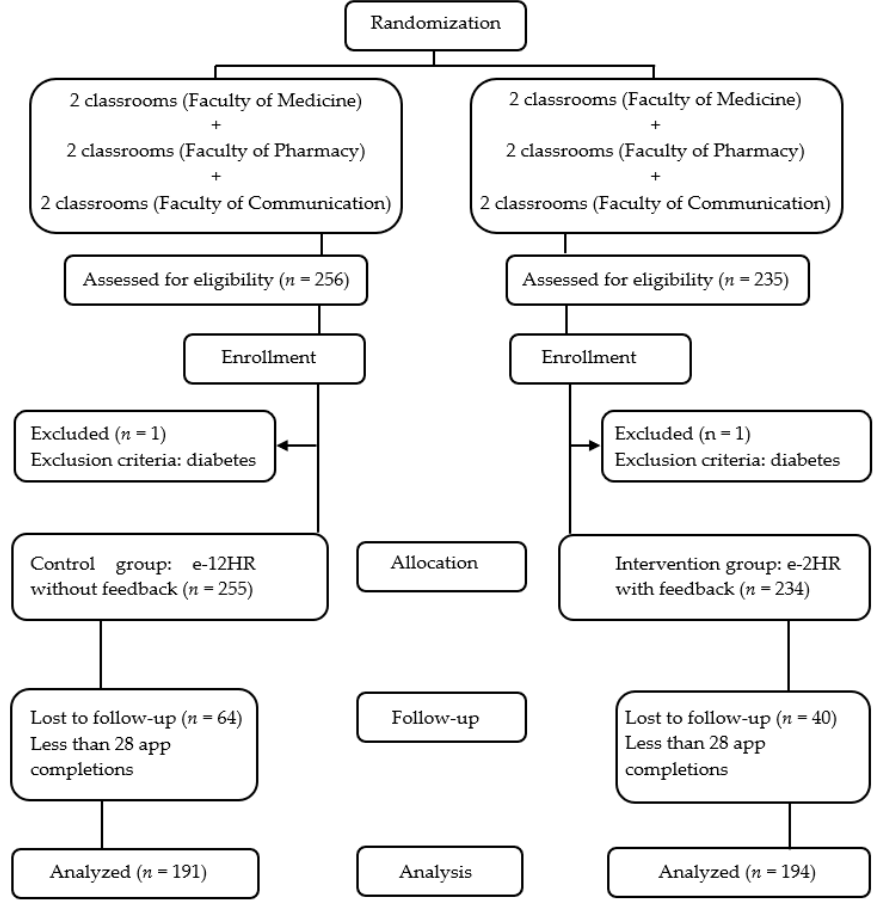
Figure 1. Flowchart of the Study.